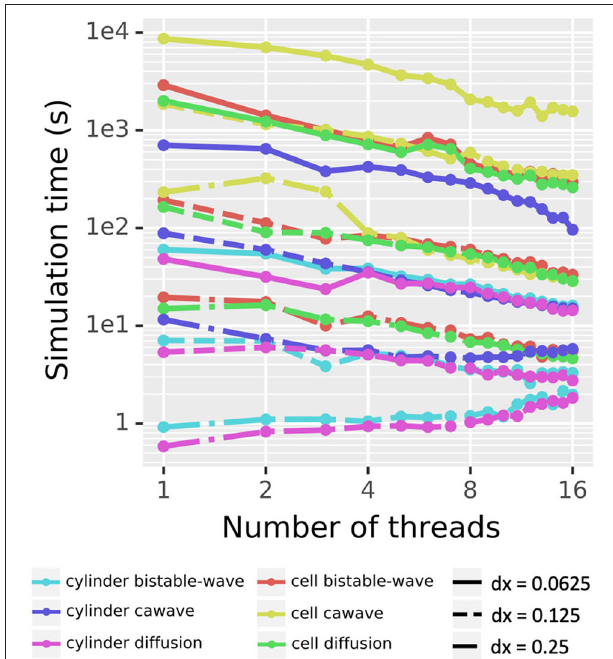
FIGURE 11 | Parallel scaling. Testing all 18 combinations of two choices of morphology, three choices of model, and three choices of dx shows decreased real time for simulation for most combinations as the number of threads increases from 1 to 16. Pure diffusion and a bistable wave on a cylinder at dx = 0.25 µ m were the only two test cases that took more real time with 16 threads than with 1 thread. Solid lines indicate dx = 0.0625 µ m, dashed lines dx = 0.125 µ m, and dash-dot lines dx = 0.25 µ